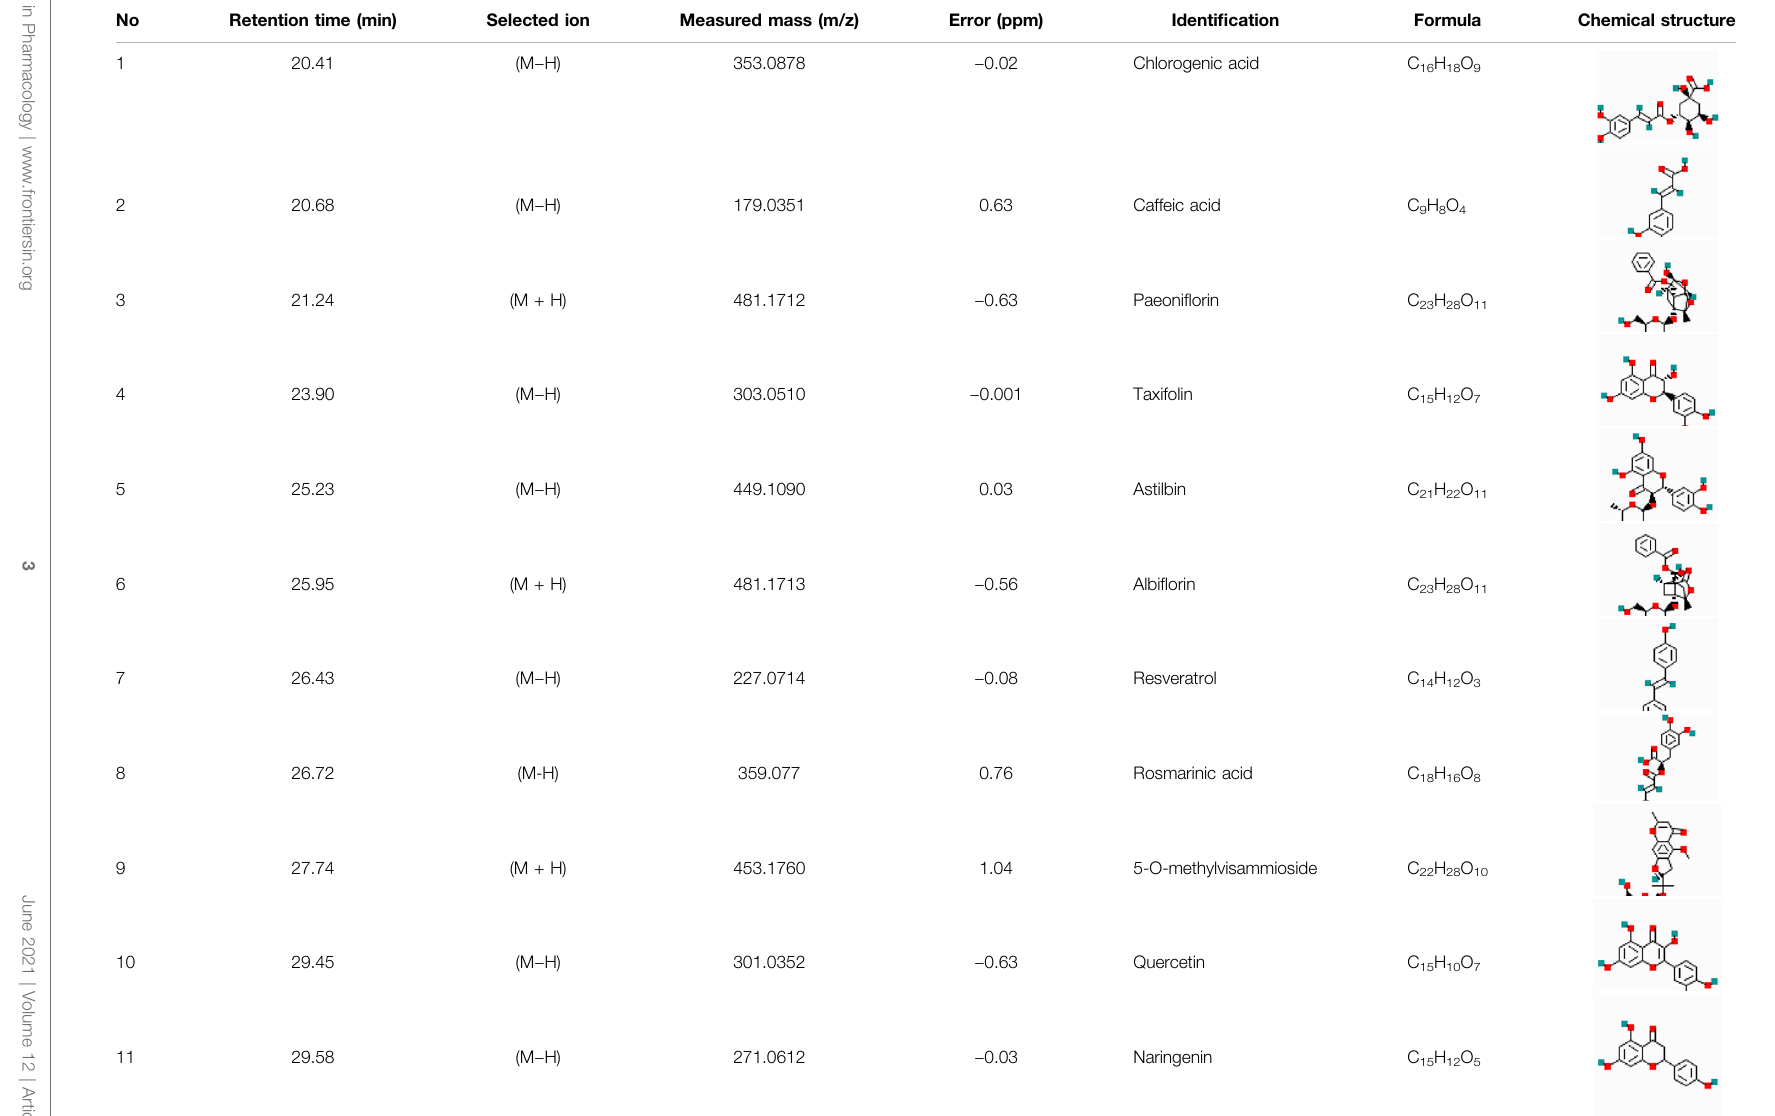
TABLE 1 | Identi fi cation of the chemical constituents of LXJD formula by UHPLC-ESI-MS analysis.